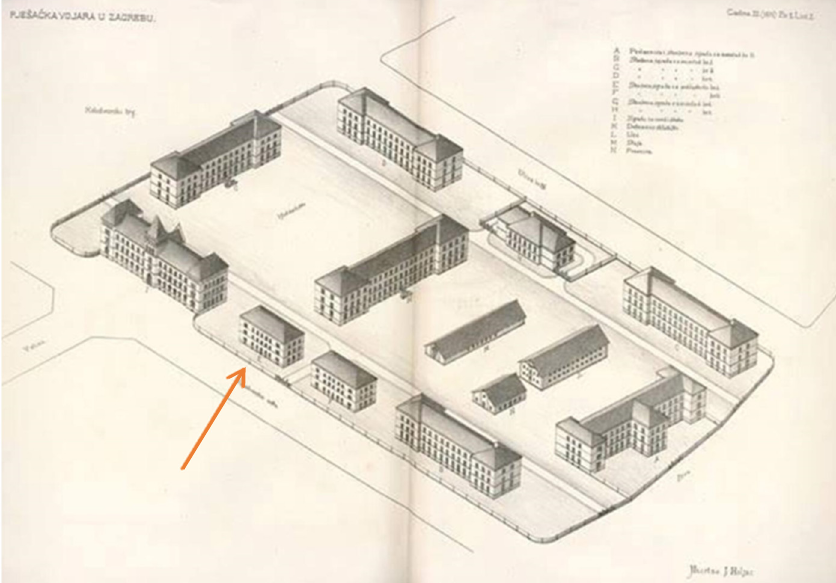
Figure 1. Rudolf’s barracks complex (archive sketch) with marked case study building.